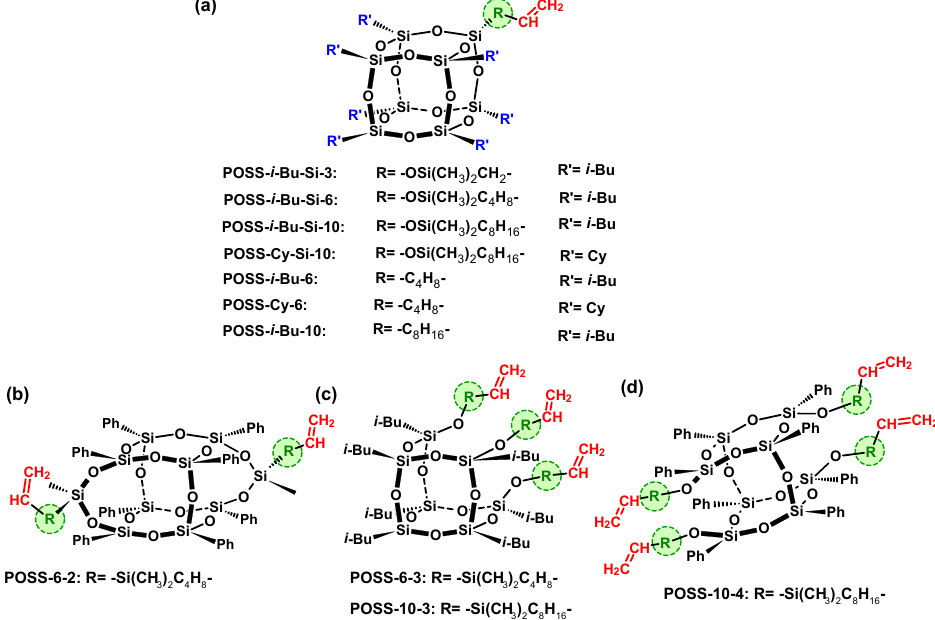
Figure 6. Structures of silsesquioxanes containing: monoalkenyl ( a ), dialkenyl ( b ), trialkenyl ( c ), tetraalkenyl ( d ) reactive substituents [71–79].